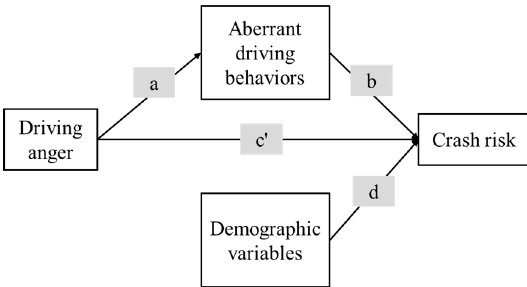
Figure 1. Framework of the mediated model proposed and tested in this study. It is hypothesized that the effects of driving anger on crash risk would be fully mediated by aberrant driving behaviors (i.e., a*b ≠ 0, and c’ = 0).